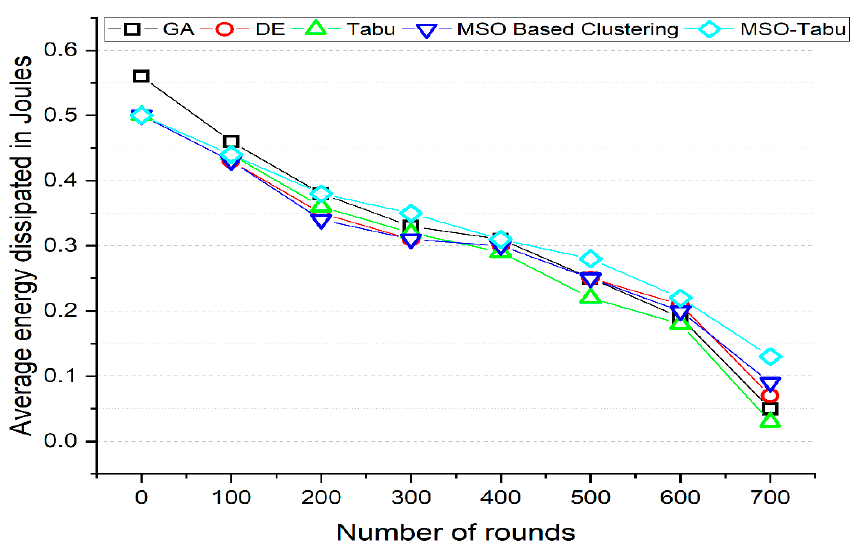
Figure 5. Average energy dissipated in Joules for MSO-Tabu.